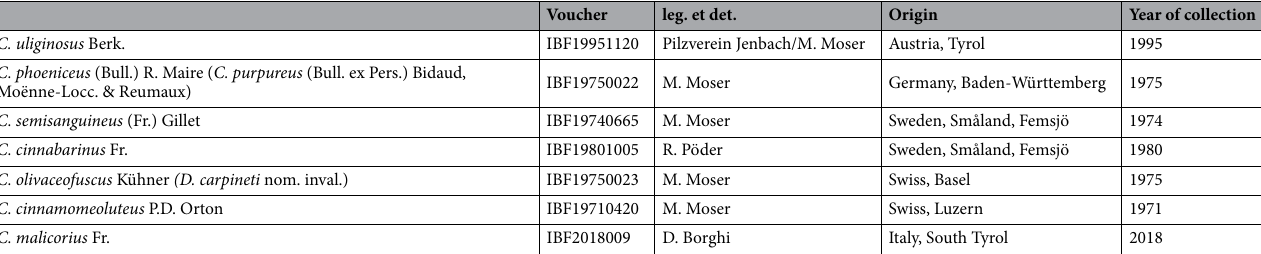
Table 2. Cortinarius collections used in this study with respective voucher numbers and collection